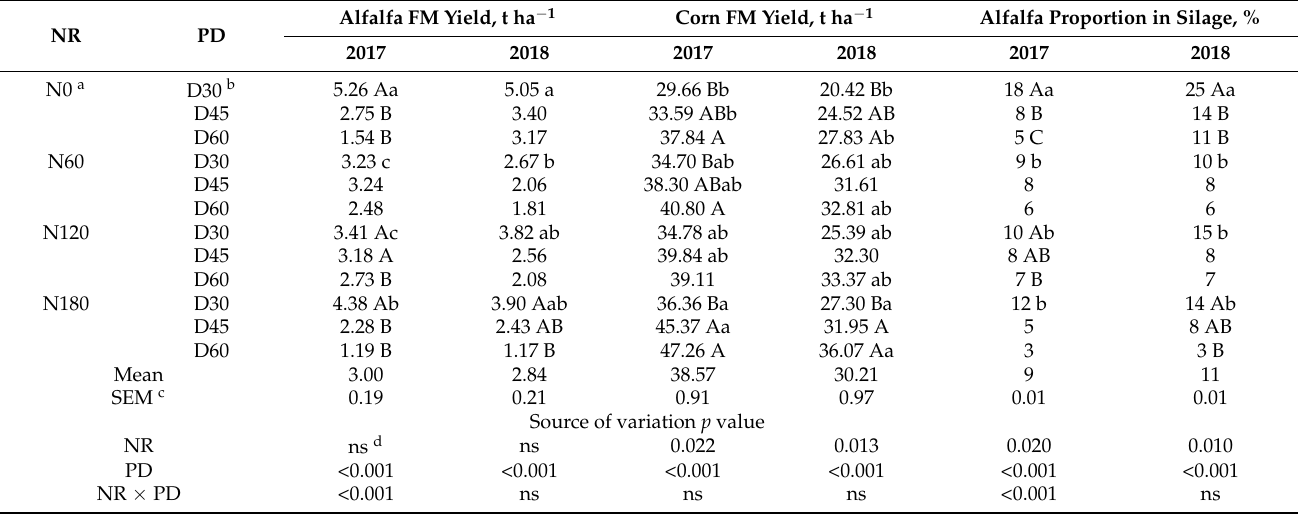
ns ns ns <0.001 ns Different lowercase letters in the same column indicate significant differences at p < 0.05 among N application rates under the same corn plant density, and different capital letters in the same column indicate significant differences at p < 0.05 among corn plant densities under the same N rate. a N0, N60, N120 and N180 mean